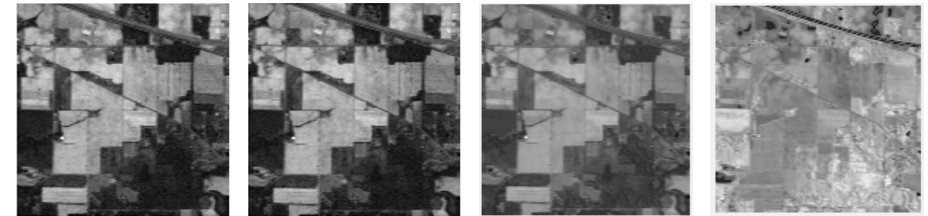
Figure 6. Grayscale images of the 1-st, 61-st, 121-st, and 181-st bands in Indian data after being